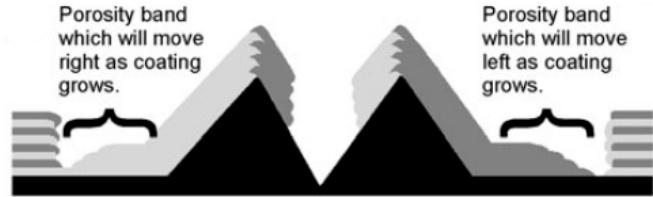
Figure 3. Schematic of shadow effect—adapted from [9].